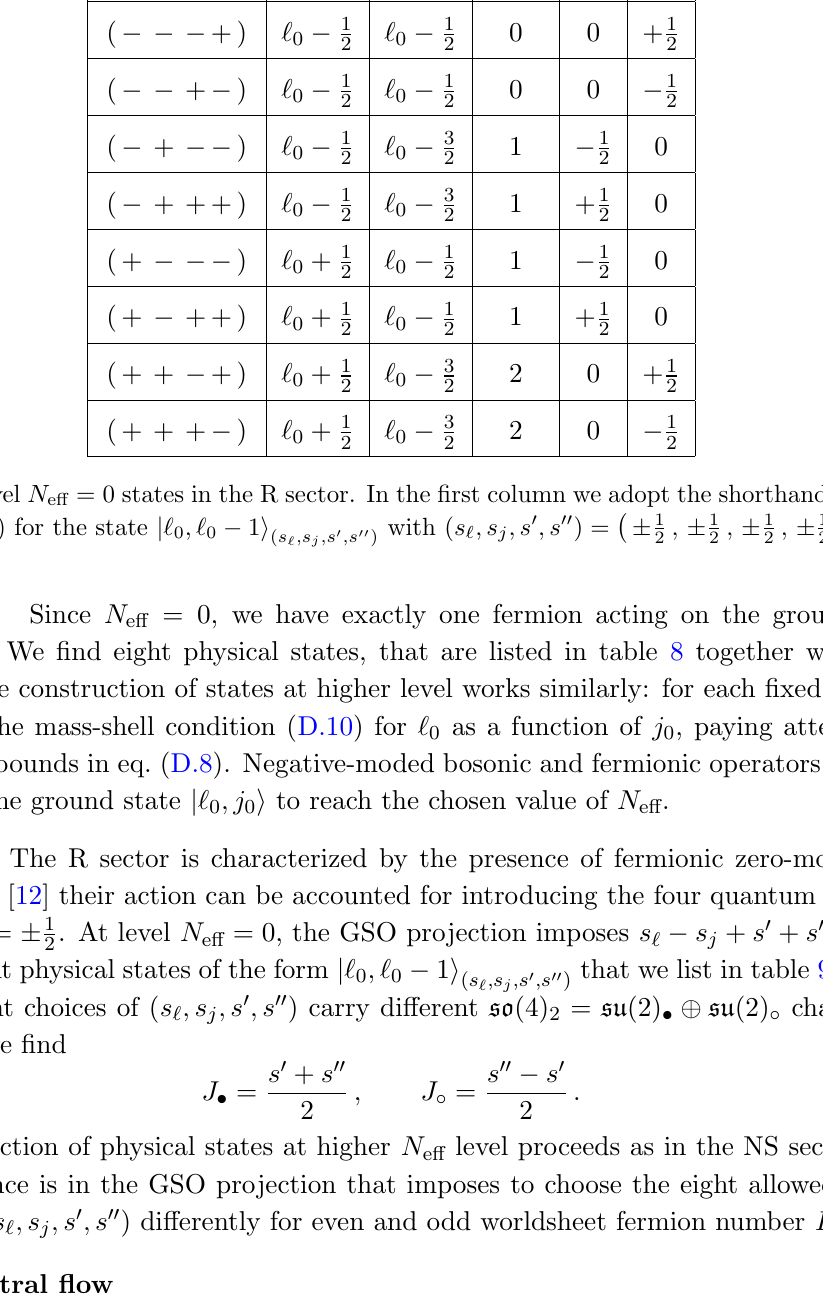
with ( s ‘ ; s j ; s 0 ; s 00 ) = ( s ‘ ;s j ;s 0 ;s 00 )